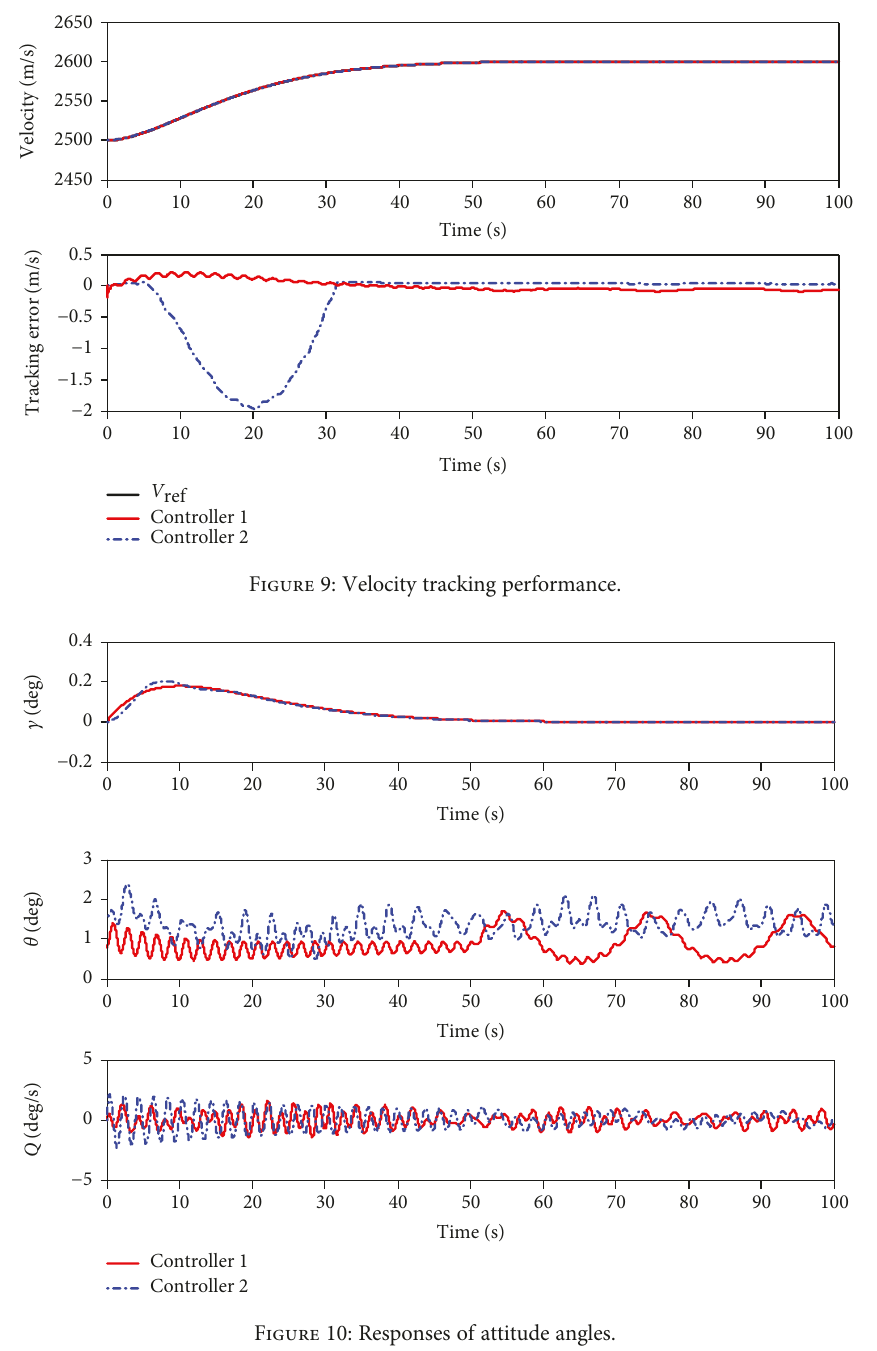
Figure 10: Responses of attitude